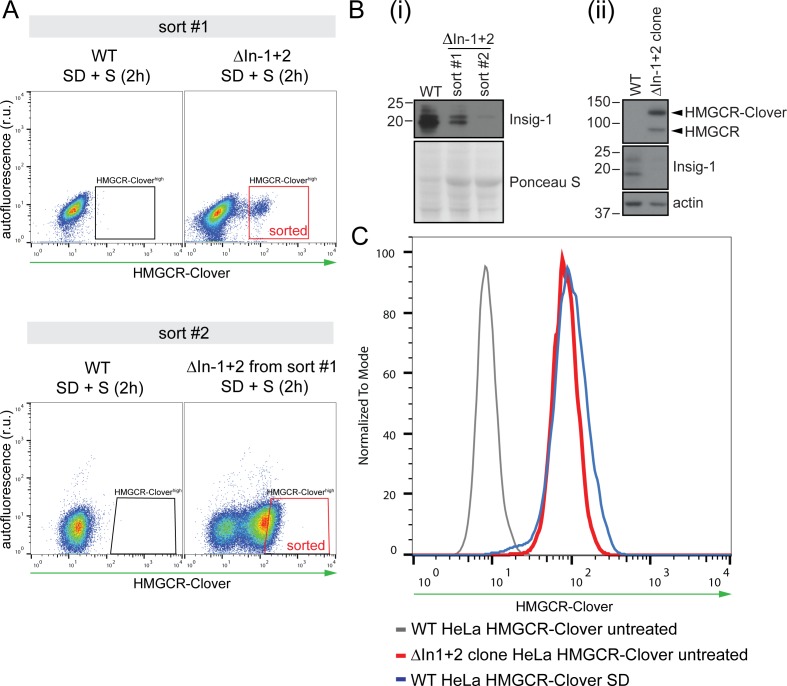
Generation of Insig knockout cell lines.(A) HeLa HMGCR-Clover cells expressing Cas9 were transfected with four sgRNAs targeting Insig-1 and Insig-2 (ΔInsig-1+2), and selected with puromycin. Due to the low initial enrichment of Insig-1+2 double knockouts in this experiment, double knockouts were further enriched by two consecutive rounds of FACS (‘sort #1’ and ‘sort #2’), selecting cells with high constitutive HMGCR-Clover expression (‘sorted’, red box) after overnight sterol depletion (SD) and sterol repletion (S) for 2 hr. r.u., relative units. (B) Immunoblotting for endogenous Insig-1 in cells isolated from sort #1 and #2 in (A) (i) and in the Insig-1+2 double knockout clone (ΔIn-1+2 clone) isolated from the enriched population in sort #2 (ii). Insig-2 expression could not be assessed by immunoblotting due to the lack of a working Insig-2 antibody and/or low expression levels in these cells. (C) Validation of the Insig-1+2 double knockout clone isolated by single-cell sorting from the sort #2 population in (A). Loss of both Insigs was confirmed by presence of sterol-independent, constitutive expression of HMGCR-Clover due to de-repression of the SCAP-SREBP2 complex (red line). HMGCR-Clover expression under steady-state conditions in Insig-1+2 double knockout cells is comparable to that of the sterol-depleted (SD, 20 hr) parental WT cell line (blue line). Loss of Insig-1 in the Insig-1/2 double knockout single cell clone was further confirmed by immunoblotting (see (B) and Figure 6E).